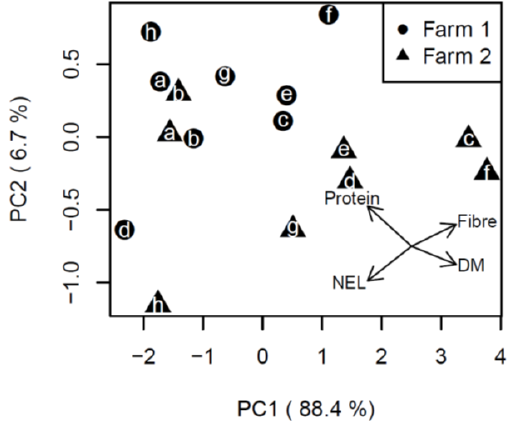
Figure 1. Result of the Principal Component Analysis (PCA) on feed quality parameters. The PCA revealed that PC1 explains more than 88% of the variance in the data, reflecting a gradient from energy- and protein-rich feed (PC1 < 0) to fiber-rich feed (PC1 > 0). The arrows in the lower right indicate the loadings of the different parameters on the first two components (DM = dry matter, NEL = net energy lactation), and the shape of the symbols represents the two different farms. The letters in the symbols reflect the eight different trials (a–h) on each farm to enable the link to Table